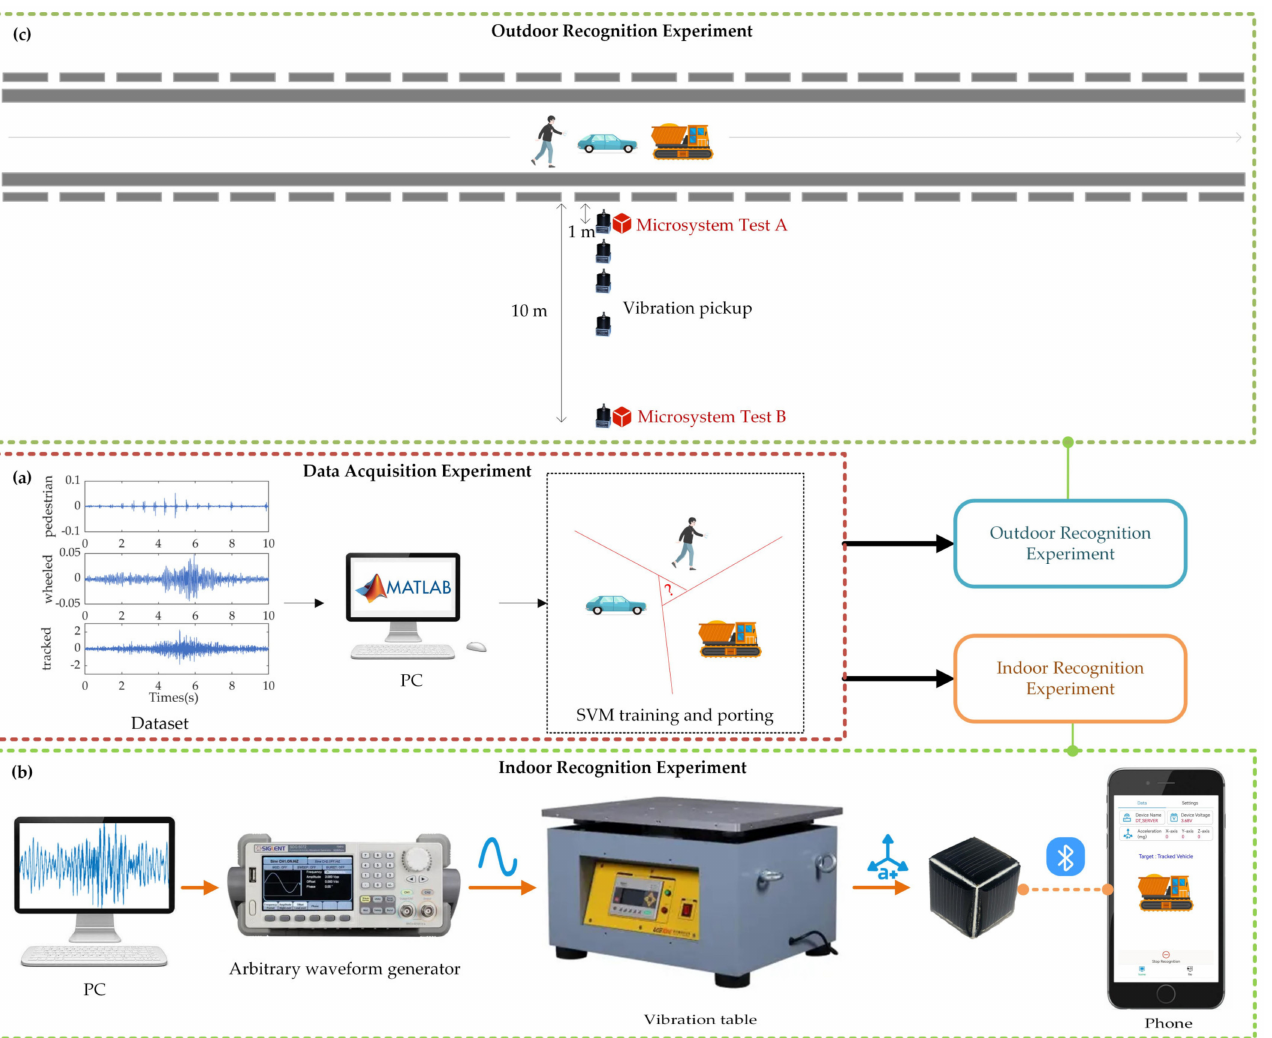
Figure 8. Sensing and Recognition Experiment.